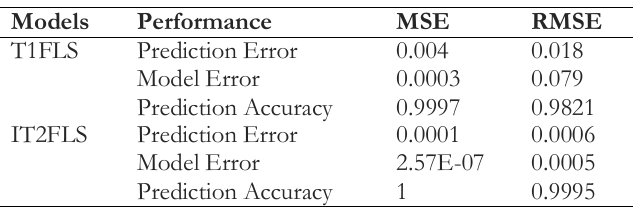
Table 6. Comparison of T1FLS and IT2FLS in shock level